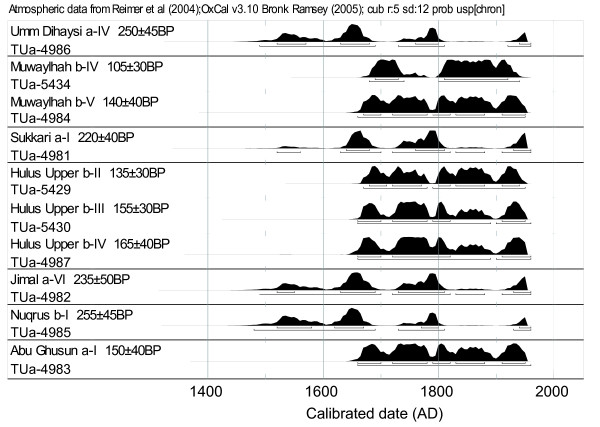
Probability distributions of calibrated dates for samples older than AD 1950. The radiocarbon age gives ambiguous calibrated dates for all samples; i.e. wood is formed in the period between 1650 and 1950. Samples with conventional radiocarbon ages of more than 200 years might have been formed as far back as the 16th century. Roman numerals refer to locations of samples in the core (Fig. 3). Horizontal lines below probability distributions represent the 1 (upper) and 2 sigma ranges of calibrated dates.